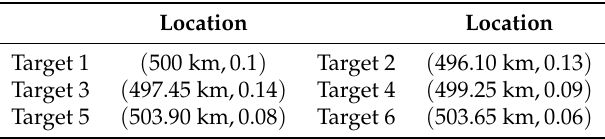
Table 1. Locations of sparse